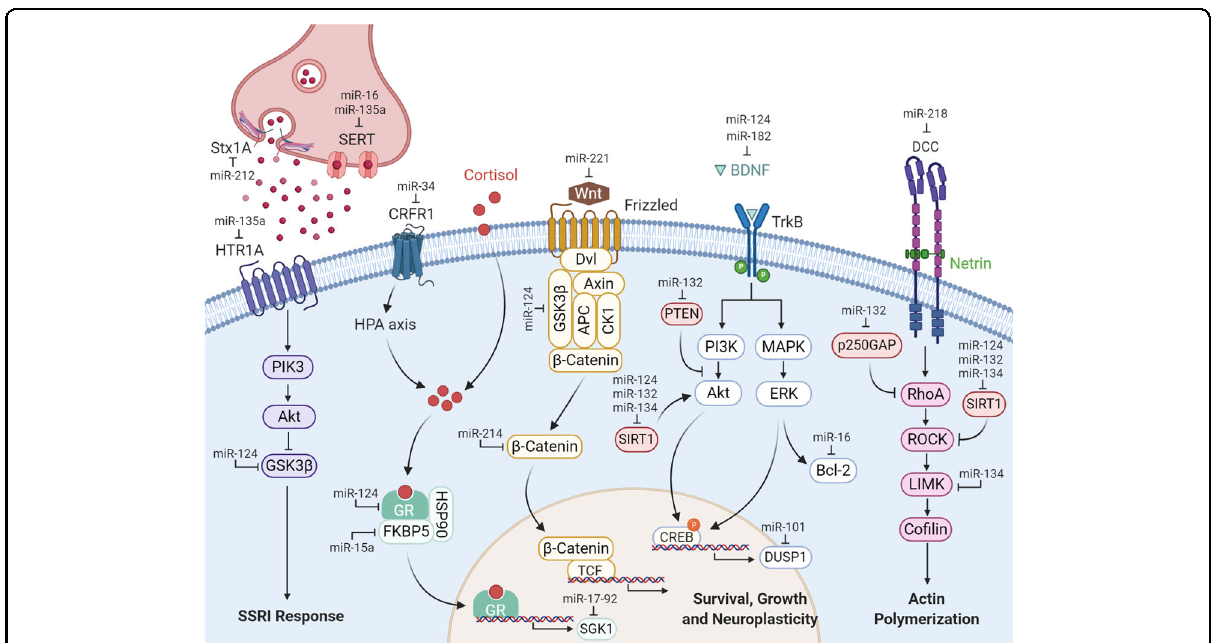
Fig. 1 miRNAs affect animal behavior related to MDD and BD by regulating the expression of genes involved in serotonergic neurotransmission and signaling pathways activated by glucocorticoids, BDNF, Wnt, and guidance cues. Typical antidepressants, such as SSRIs, block monoamine reuptake by the SERT and, when chronically administered, lead to the desensitization of serotonin receptors (HTR) 21 . Signaling by glucocorticoids, BDNF, and Wnt controls multiple physiological functions such as neuronal survival, growth, and plasticity 61,110,149 . During development, the Netrin-1/DCC pathway plays a critical role in axonal outgrowth toward the prefrontal cortex and the organization of mPFC connectivity in adulthood 150 . Created with BioRender.com. Abbreviations: Stx1A, syntaxin 1A; SERT, serotonin transporter; HTR1A, serotonin receptor 1A; PIK3, phosphoinositide 3-kinase; Akt, protein kinase B; GSK3 β , glycogen synthase kinase 3 beta; SSRI, selective serotonin reuptake inhibitor; CRFR1, corticotropin-releasing factor receptor 1; HPA axis, hypothalamus – pituitary – adrenal axis; GR, glucocorticoid receptor; FKBP5, FK506-binding protein 5; HSP90, heat shock protein 90; SGK1, serum- and glucocorticoid-inducible protein kinase-1; Wnt, Wingless-related integration site; Dvl, dishevelled protein; APC, adenomatous polyposis coli protein; CK1, casein kinase 1; TCF, T cell factor; BDNF, brain-derived neurotrophic factor; TrkB, neurotrophic receptor tyrosine kinase 2; PTEN phosphatase and tensin homolog; SIRT1, sirtuin 1; CREB, cAMP response element-binding protein; DUSP1, dual- speci fi c phosphatase 1; MAPK, mitogen-activated protein kinase; ERK, extracellular signal-regulated kinase; Bcl-2, B-cell lymphoma 2; DCC, deleted in colorectal carcinoma; p250GAP, Rho GTPase activating protein 32; RhoA, Ras homolog family, member A; ROCK, Rho-associated coiled-coil kinases; LIMK, LIM motif-containing protein